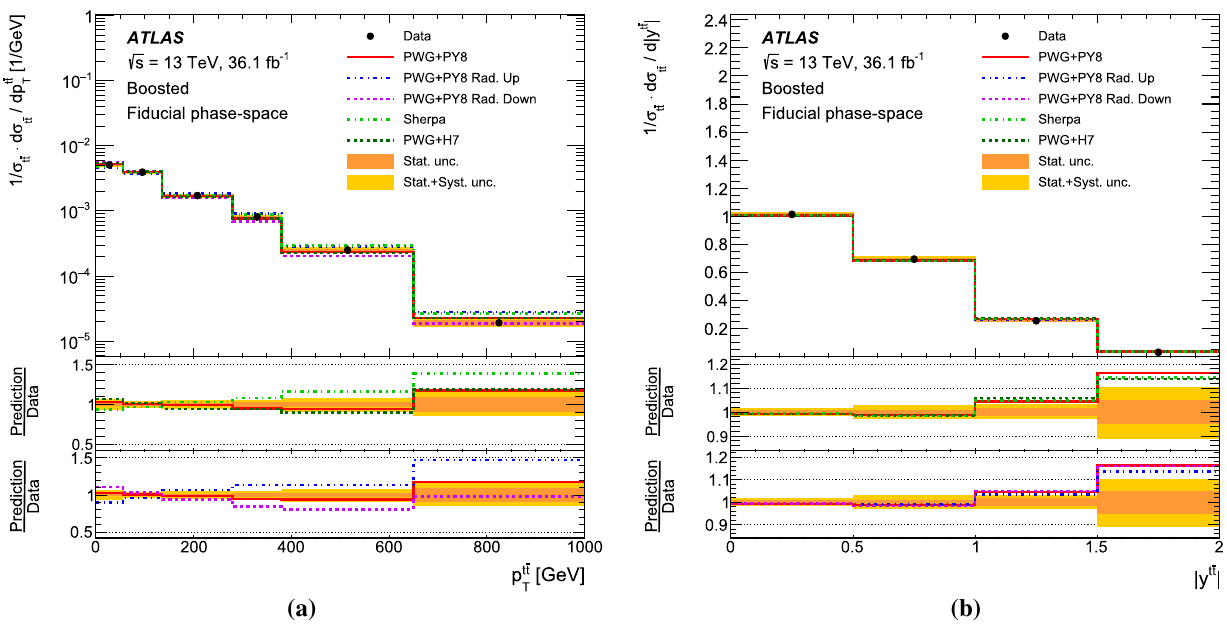
Fig. 39 Particle-level normalised differential cross-sections as a func- tion of a the transverse momentum and b the absolute value of the rapidity of the t ¯ t system in the boosted topology, compared with dif-